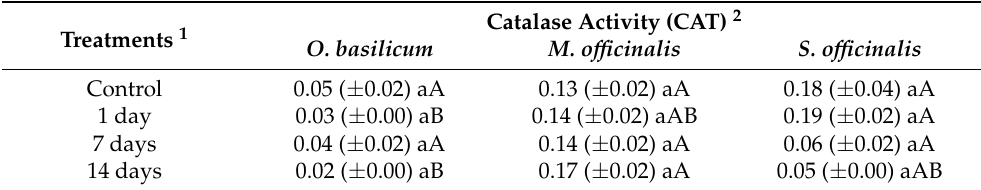
Table 6. Catalase activity (U mg − 1 FW) within leaves of Ocimum basilicum , Melissa officinalis and Salvia officinalis after Tetranychus urticae infestation. Treatments